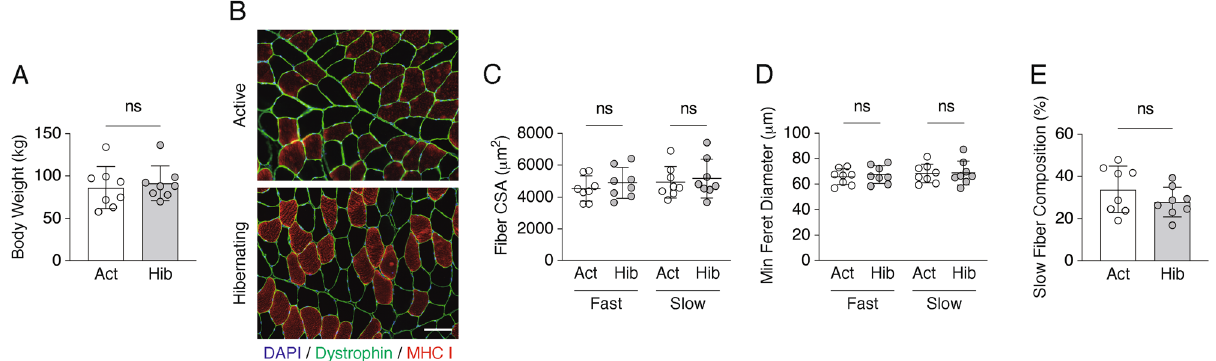
Figure 1. Body weight and muscle fiber cross-sectional areas: active vs. hibernation periods. The body weight, muscle fiber size, and fast-/slow-fiber type composition were not altered in Asiatic black bears during hibernation. During the 2017–2018 season, skeletal muscle samples (vastus lateralis muscle) were collected from each of the same individual bear under anesthesia in mid-July (normal activity period) and in late February (hibernation period). n = 8 in each group. ( A ) Body weight (kg). ( B ) Typical images of cross sections with immunohistochemistry (blue; nuclei localization with 4 ′ ,6-diamidino-2-phenylindole, green; dystrophin localization, red; localization of slow-type fiber with anti-myosin heavy chain slow antibody) are shown. The scale bar shows 100 μm. The mean size ( C ) and minimum Feret diameter ( D ) of muscle fibers were obtained for each sample followed by the determination of group data. ( E ) The composition (%) of slow muscle fibers was calculated by counting a total of 400–800 myofibers from different regions in each sample. All results are expressed as mean ± standard deviation